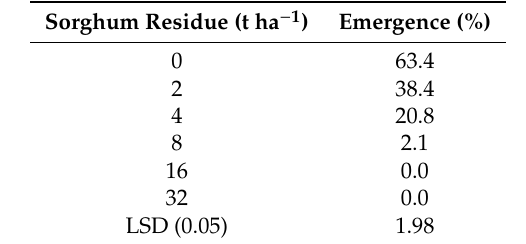
Table 2. The e ff ect of di ff erent sorghum residue amounts on the seedling emergence of three biotypes of Brachiaria eruciformis . Each value of the table represents a mean value of the germination data (pooled across biotypes), as no significant di ff erences were observed among